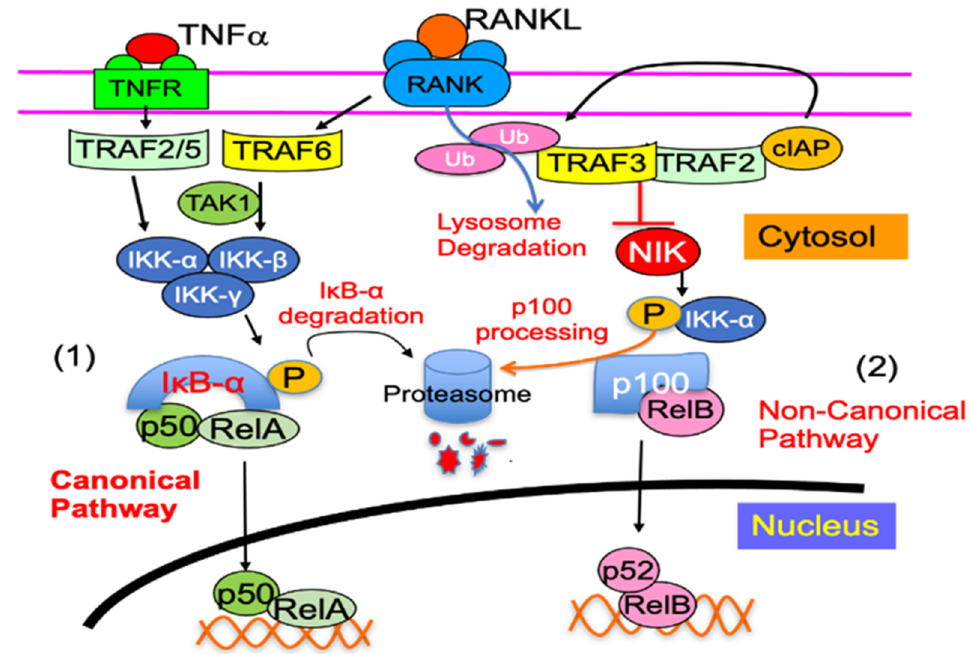
Figure 2. NF- κ B signaling pathway. (1) Canonical NF- κ B activation. Cytokines, such as RANKL and